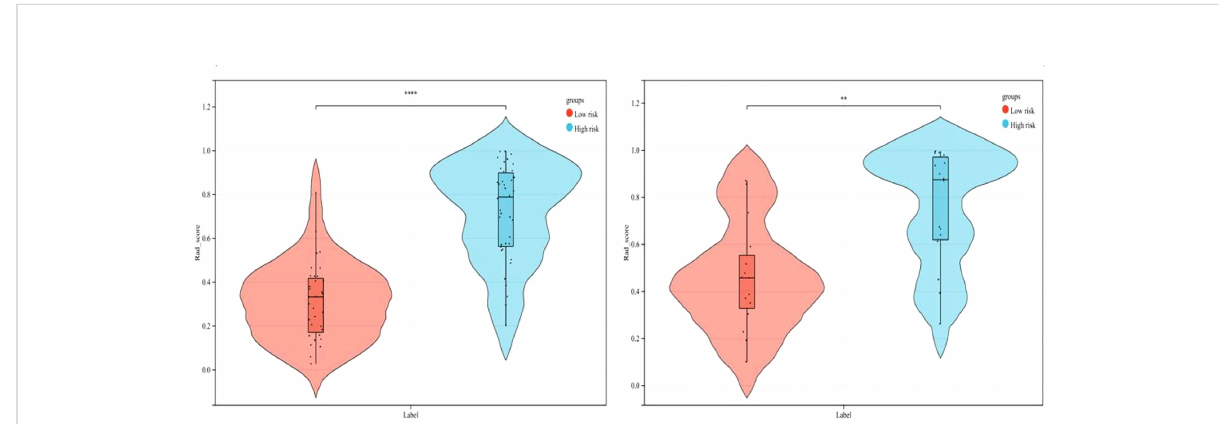
FIGURE 5 Comparison of radiomics score between low-risk and high-risk thymomas in the training and validation sets (left, training set; right, validation set).